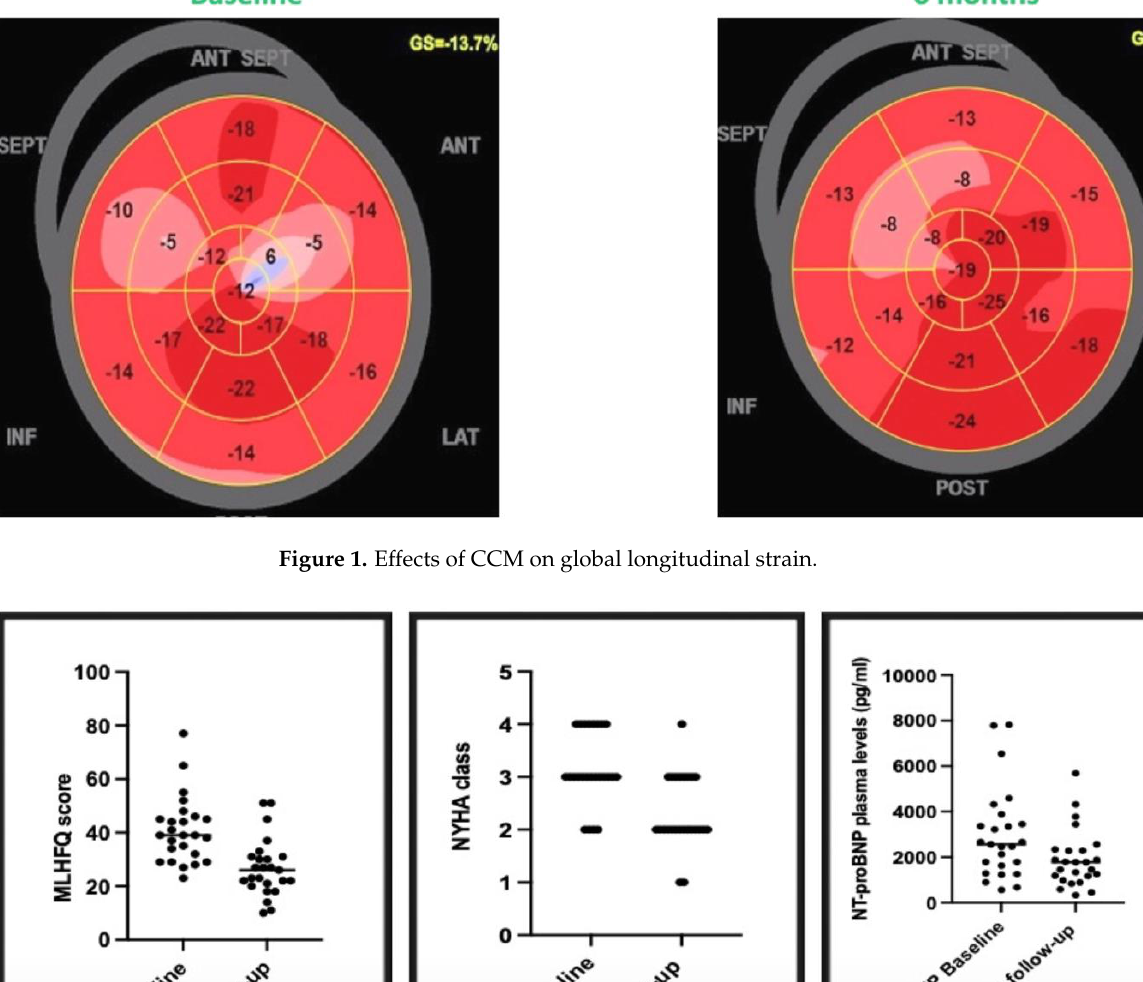
Figure 1. Effects of CCM on global longitudinal strain.